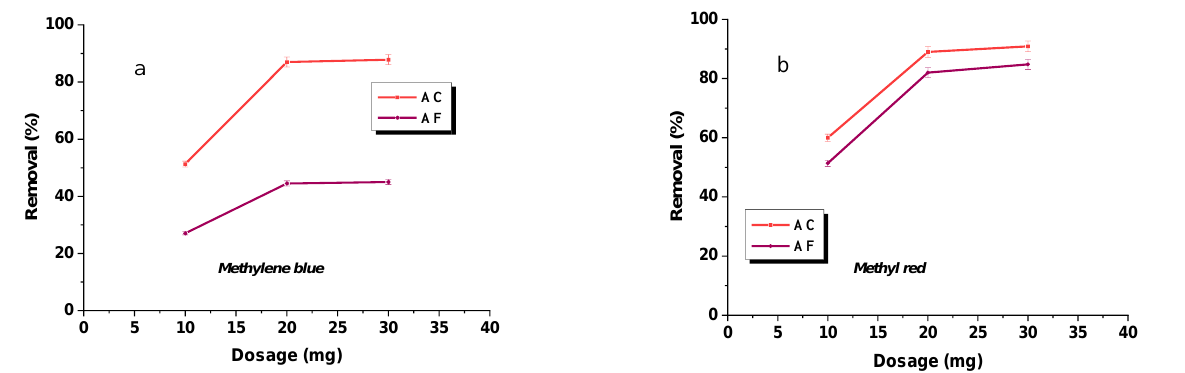
Figure 8. Effect of adsorption efficiency on the adsorption of methylene blue ( a )/methyl red ( b ) on activated carbon